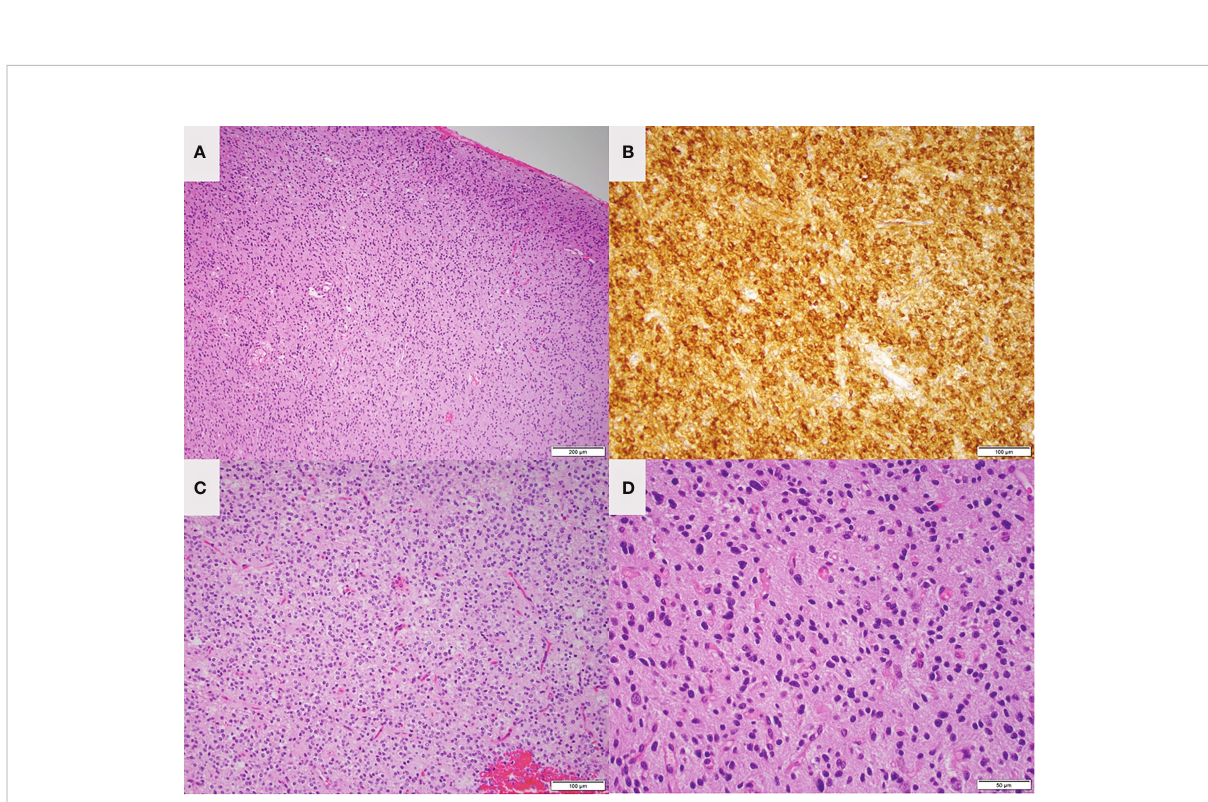
FIGURE 4 Low magni fi cation H&E staining (A) and IDH mutant staining (B) of the left frontal lesion in patient 1 are consistent with oligodendroglioma. Low magni fi cation (C) and high magni fi cation (D) H&E staining of the right temporal lesion is consistent with low-grade